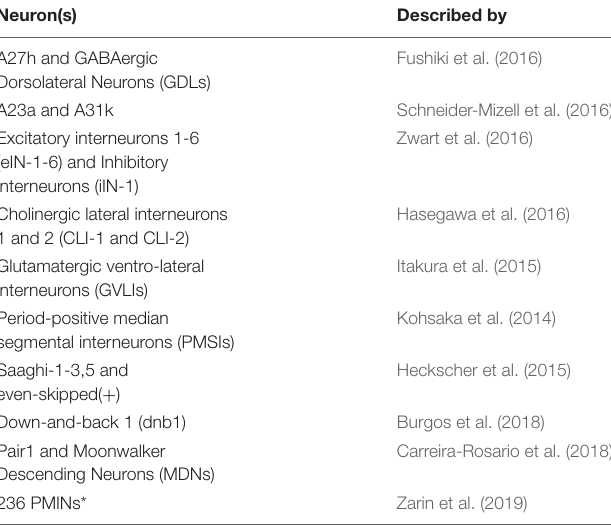
TABLE 1 | List of Identified Drosophila Larval Neurons described by TEM Reconstructions.